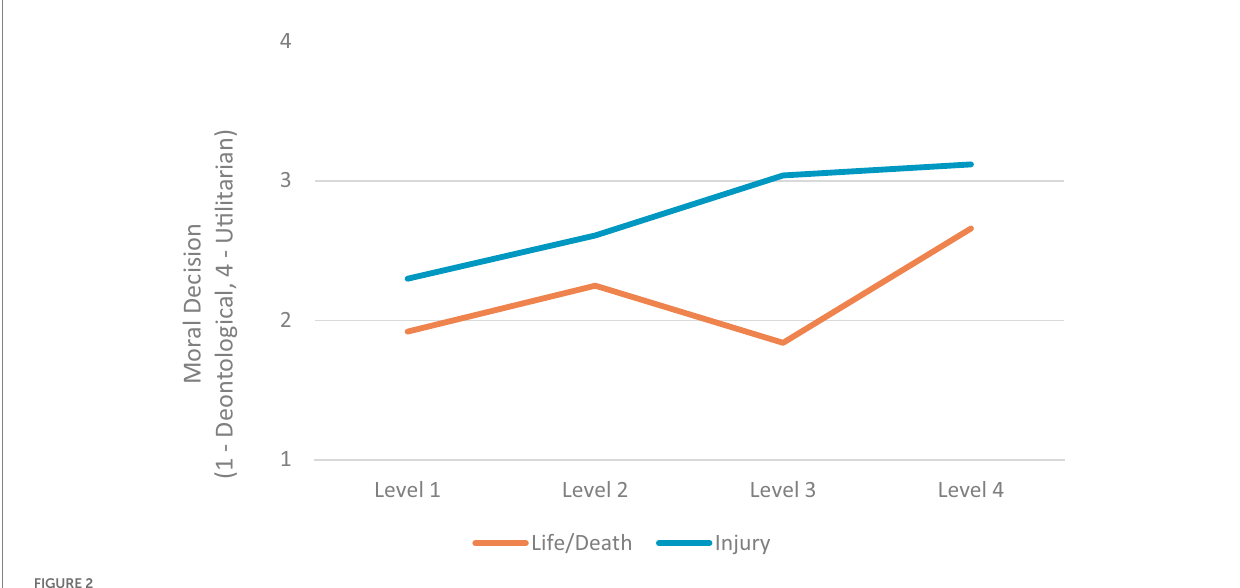
FIGURE 2 Moral decisions in different dilemma types and on different levels of